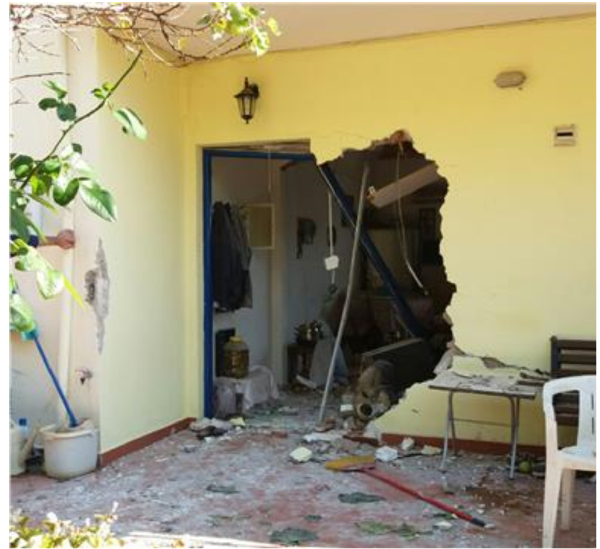
Figure 3. Damage from the falling rock on the impacted house in Ponti, Lefkada,